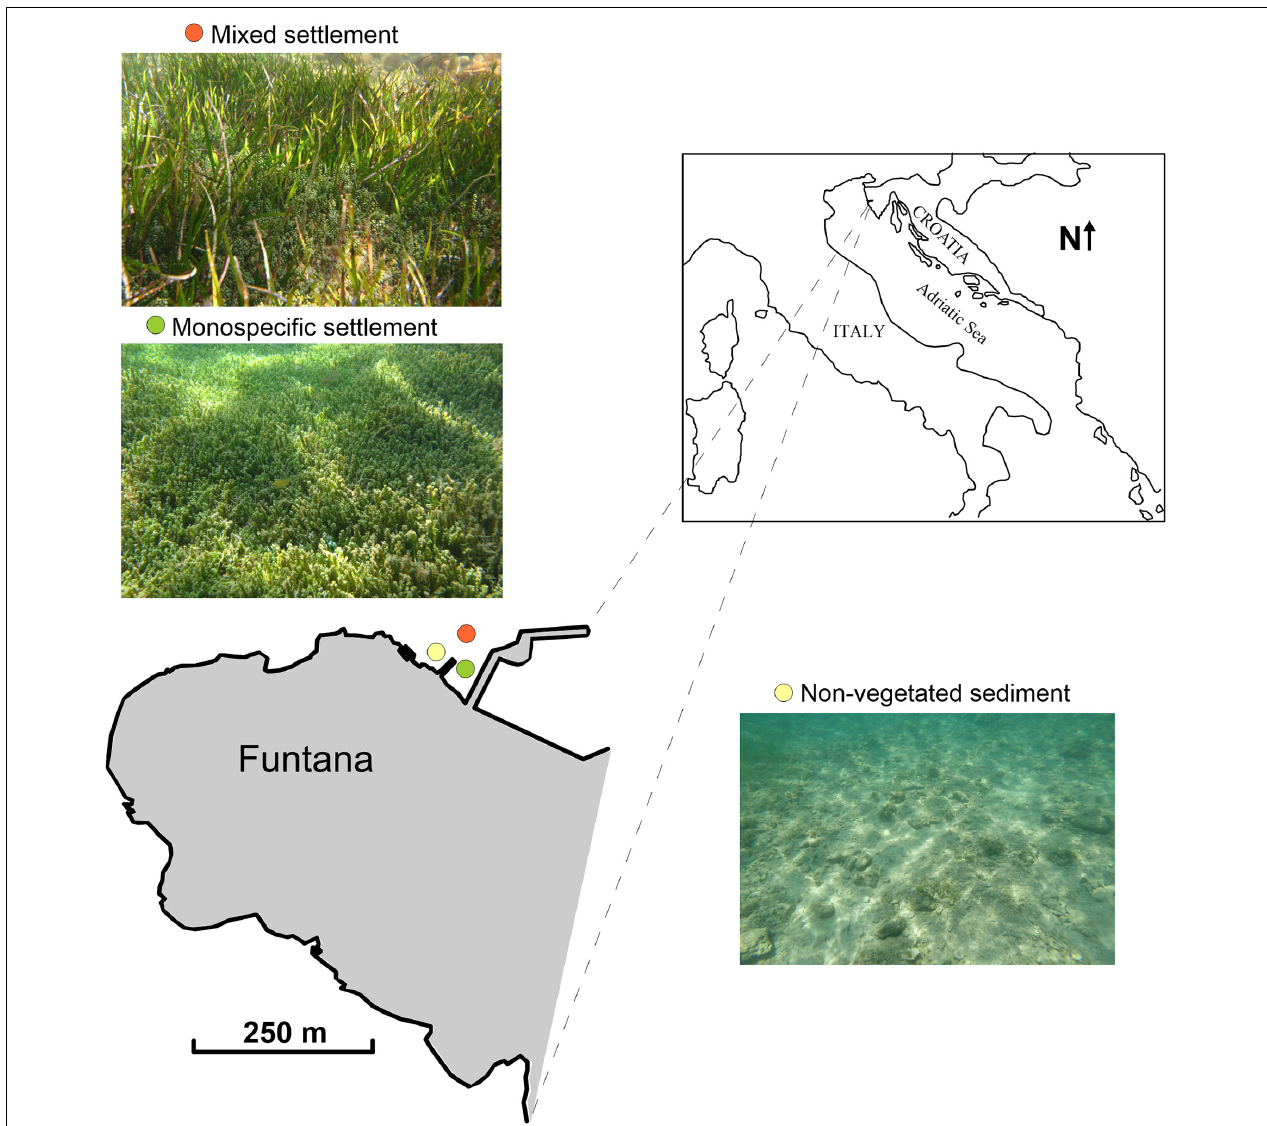
FIGURE 1 | Map of the sampling stations in Funtana Bay, northern Adriatic Sea; mixed settlement (orange), C. cylindracea monospecific settlement (green), and non-vegetated sediment